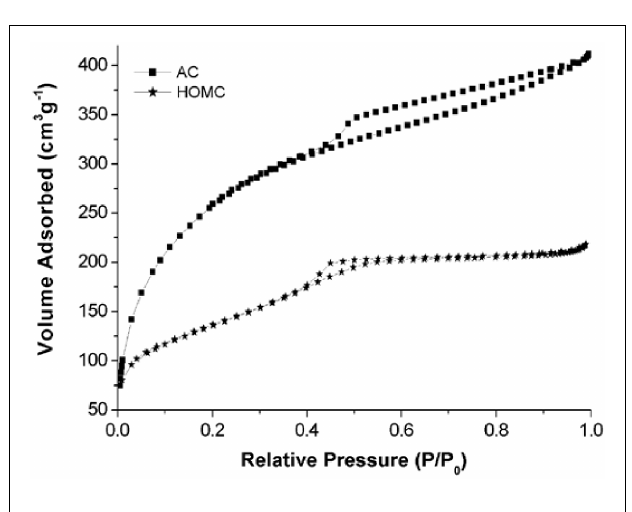
FIGURE 3 | N 2 sorption isotherms of HOMC ( (cid:70) ) andAC ( (cid:4) ) .